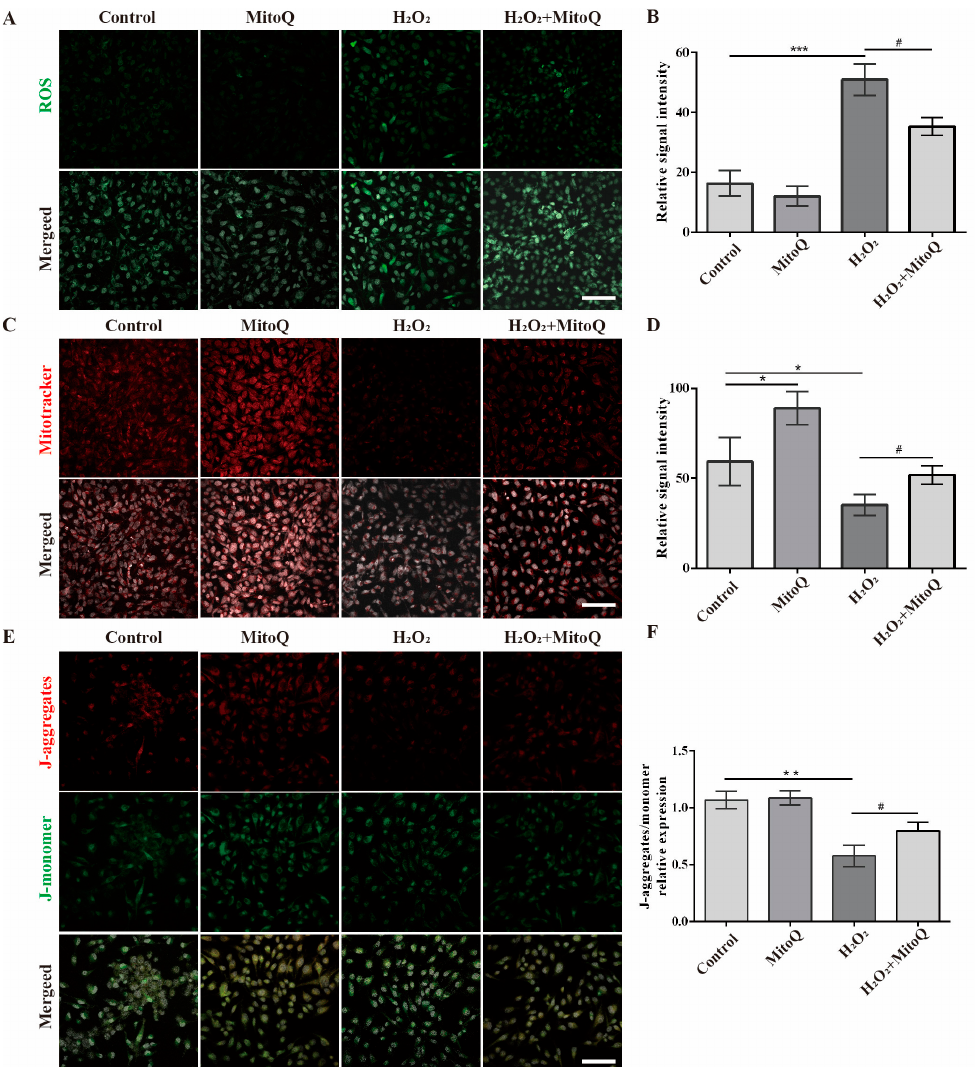
Figure 5. MitoQ protects the mitochondria in GCs from H 2 O 2 -induced oxidative stress. ( A ) DCFH- DA staining of GCs, DNA (DAPI) is shown in gray, scale bar, 100 μ m. ( B ) Relative fluorescence intensity of DCFH-DA staining in GCs (n = 3). Error bars indicate SD. *** p < 0.001, vs. control group. # p < 0.05, vs. H 2 O 2 group. ( C ) MitoTracker staining of GCs, DNA (DAPI) is shown in gray. Scale bar, 100 μ m. ( D ) Relative fluorescence intensity of MitoTracker staining in GCs (n = 3). Error bars indicate SD. * p < 0.05, vs. control group. # p < 0.05, vs. H 2 O 2 group. ( E ) JC-1 staining of GCs, DNA (DAPI) is shown in gray. Scale bar, 100 μ m. ( F ) The ratio of red to green fluorescence intensity in GCs (n = 3). Error bars indicate SD. ** p < 0.01, vs. control group. # p < 0.05, vs. H 2 O 2 group.